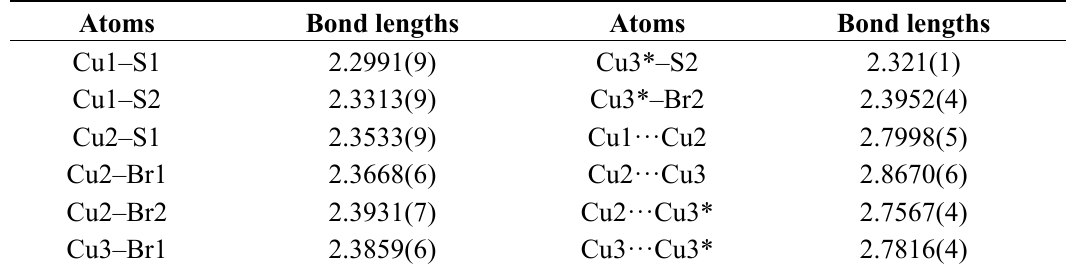
Table 1. Selected bond lengths (Å) of 1 .